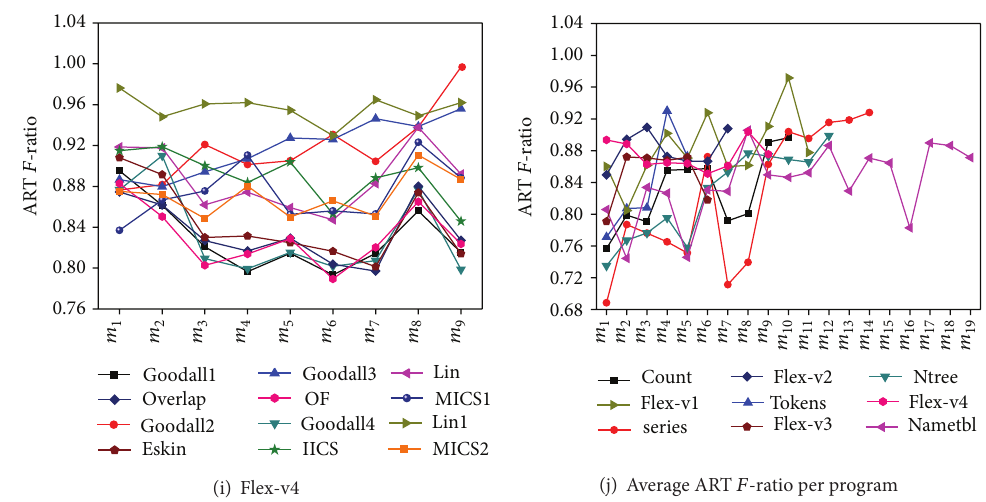
Figure 4: ART 𝐹 -ratio of FSCS-CID methods using different similarity